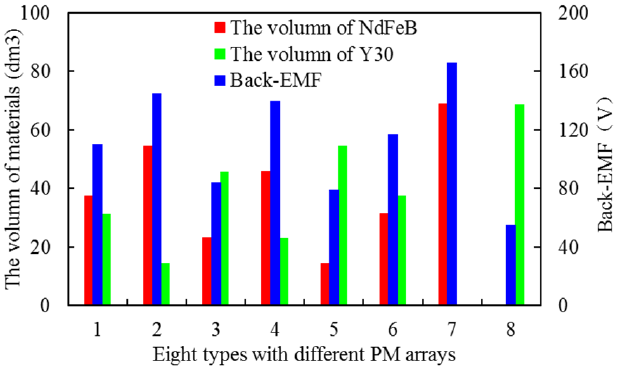
Figure 5. Volume of PMs and back-EMF of the eight types with different materials.